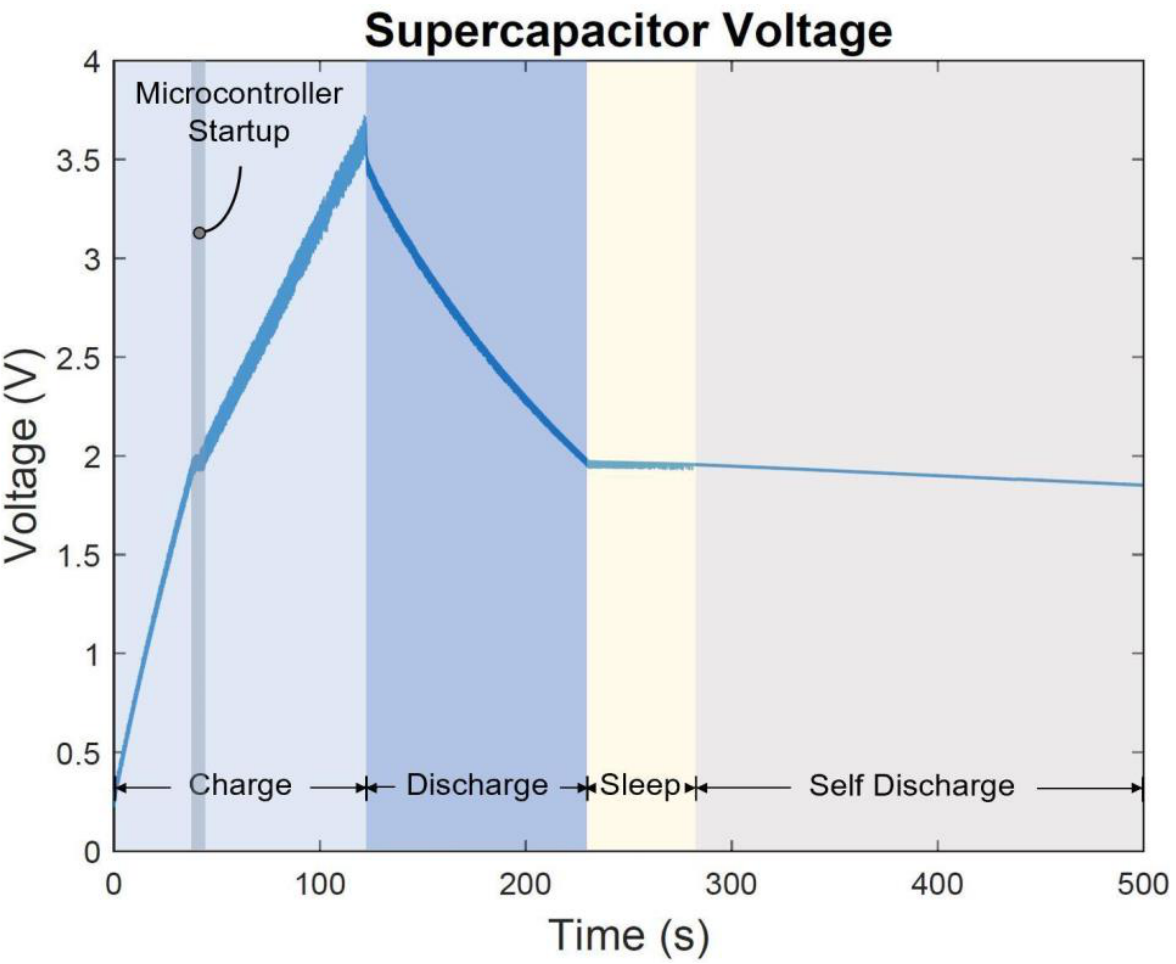
Figure 15. The supercapacitor voltage charge and discharge cycle during frequency sweep 6.5 – 15 Hz at 1 g [m/s 2 ] acceleration level.